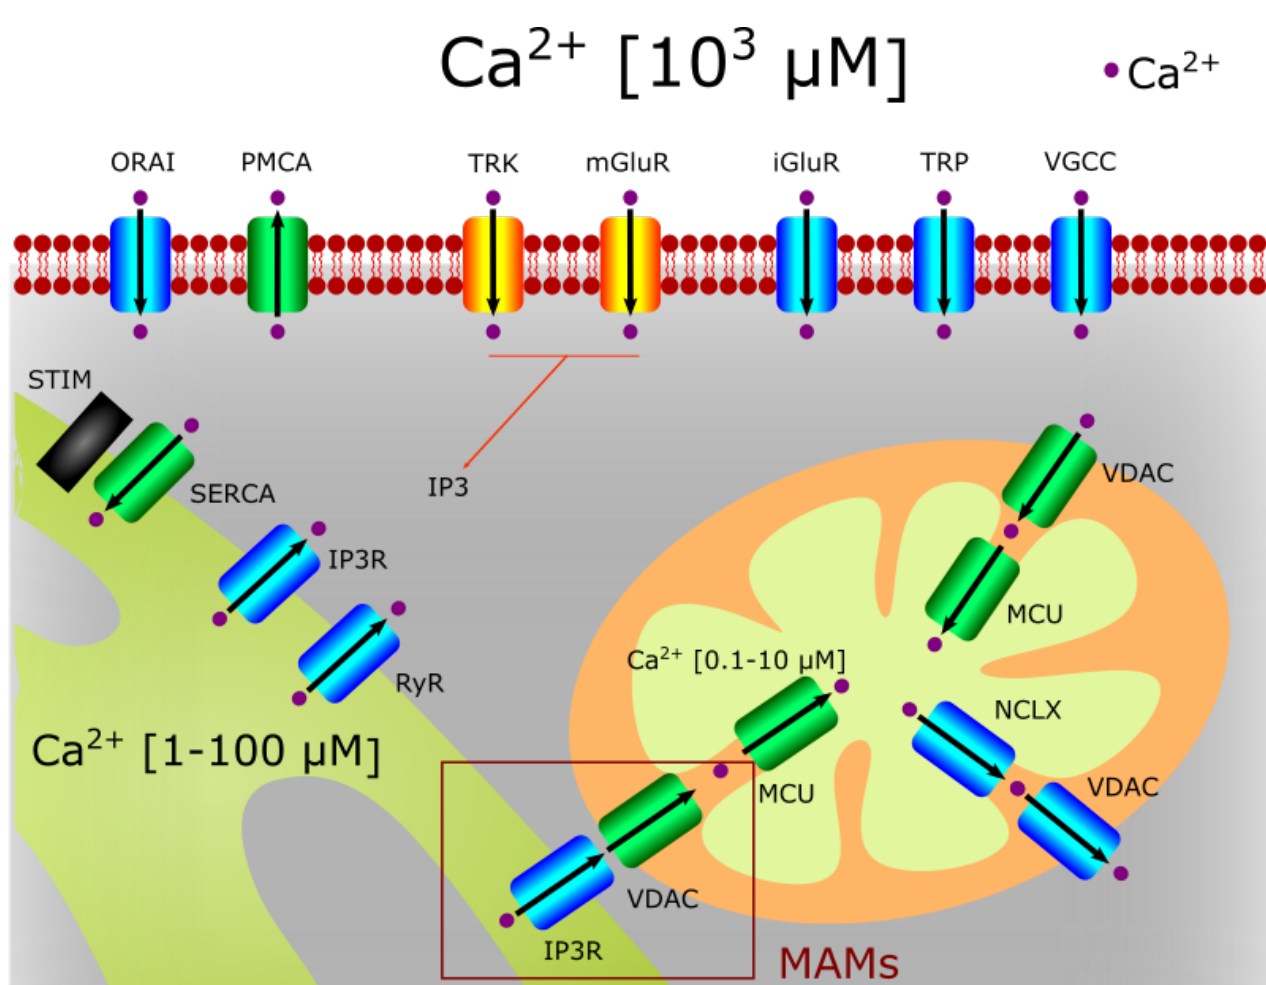
Figure 4. Ca 2+ homeostasis in neurons. The entrance of extracellular Ca 2+ into neurons is due to the direct activation of neurotransmitter and neurotrophin receptors (such as NMDAR and TRK) and cationic channels (such as TRPs or voltage activated Ca 2+ channels). The VDAC channel can import or export Ca 2+ in the mitochondria when associated to MCU or NCLX, respectively. IP3R and VDAC channels found in MAMs can also transport Ca 2+ from the ER to the mitochondria. The Ca 2+ extrusion to the extracellular medium is mediated by ATPases (i.e., PMCA).